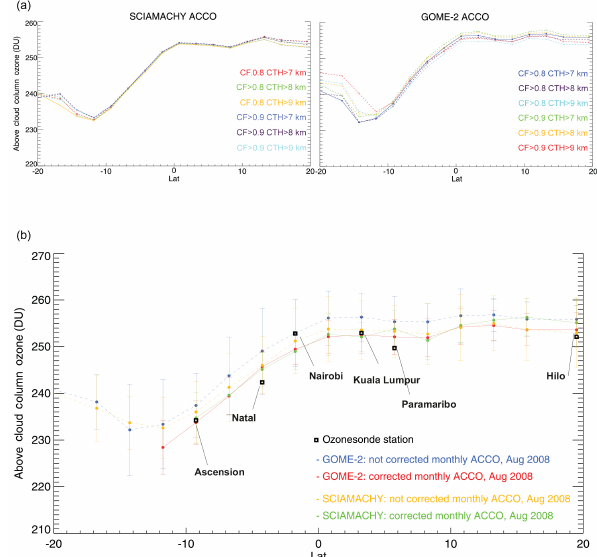
Figure 4. (a) SCIAMACHY (left) and GOME-2 (right) ACCO per 2.5 ◦ latitude bands in the Indian and western Pacific Ocean (70 ◦ E–170 ◦ W) for different cloud fractions (0.8, 0.9) and cloud- top heights (7–9km) in August 2008. (b) Above-cloud column of ozone (ACCO) for 2.5 ◦ latitude bands in the Indian and western Pa- cific Ocean from GOME-2 (CF > 0.8 and CTH > 7km) and SCIA- MACHY (CF > 0.8 and CTH > 9km) in August 2008. Blue and yellow dashed lines are the zonal ACCO values before applying any corrections for GOME-2 and SCIAMACHY respectively. Red and green lines are the zonal ACCO values after corrections ap- plied for adjusting to the 200hPa level and screening out outlier data. Error bars denote 1 σ standard deviation. Black boxes show the stratospheric ozone columns from ozonesondes, of the stations Ascension, Natal, Nairobi, Kuala Lumpur, Paramaribo, and